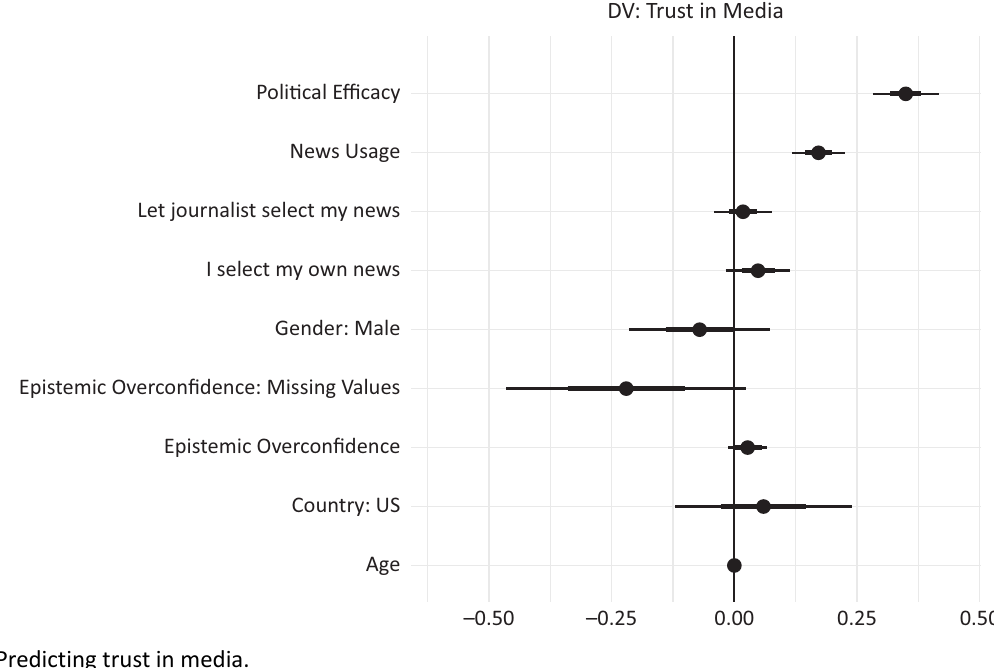
Figure 7. Predicting trust in media.